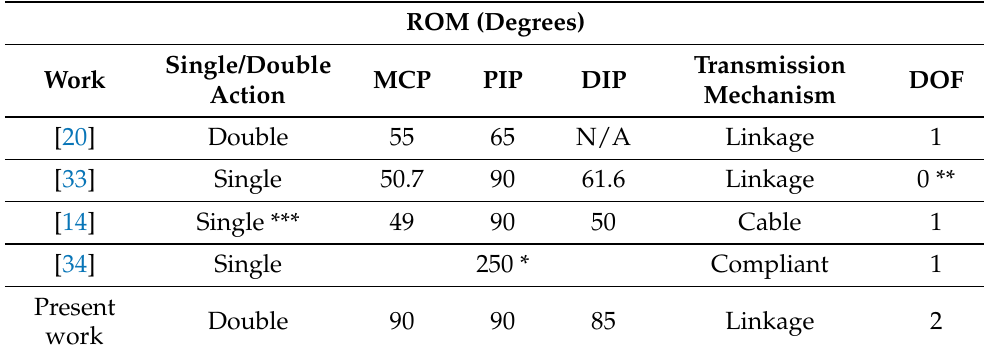
Table 3. Comparison between different works and the one presented in this document. ROM